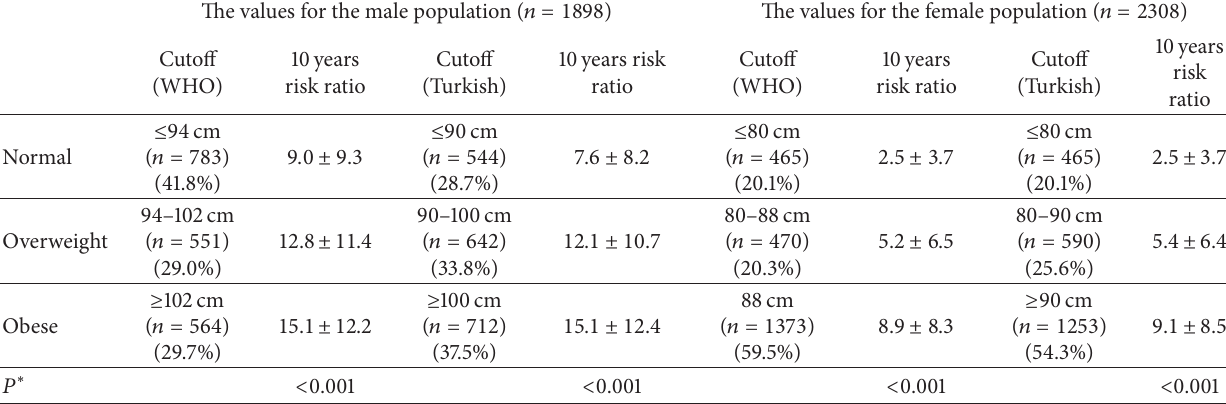
Table 3: The 10-year Framingham cardiovascular risk ratios of the Turkish adults, calculated according to the different waist circumference categories using the thresholds proposed by the world health organization and the data of the present study. The values for the male population ( 𝑛 = 1898 ) The values for the female population ( 𝑛 = 2308